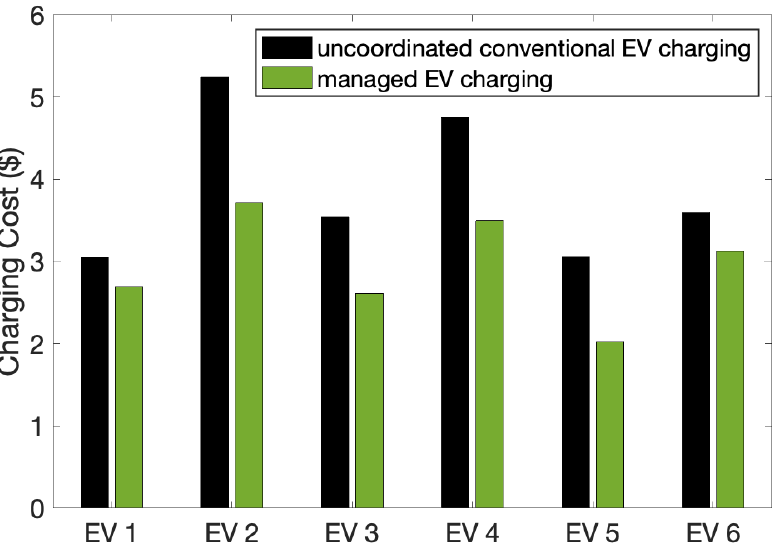
Figure 7. Comparison of charging costs of different situations.